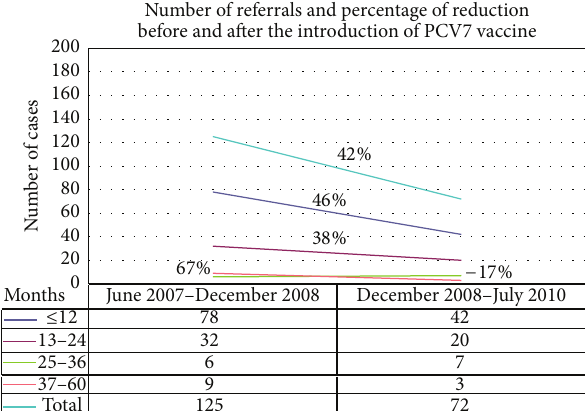
Figure 1: Number of referrals and percentage of reduction before (Jun 2007–Dec 2008) and after (Dec 2008–Jul 2010) PCV7 introduc- tion, according to patient age in